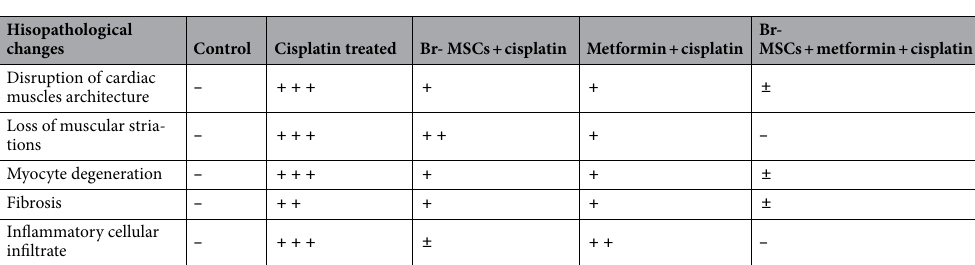
+ + Table 4. Semi-quantitative scoring showing the severity of changes in cardiac muscle and the effect of Br-MSCs, metformin, and their combination on cardiac histopathological sections. Scores were expressed as follows, (–) normal; ( ±) borderline; ( +) mild; (+ +) moderate; (+ + +) severe.